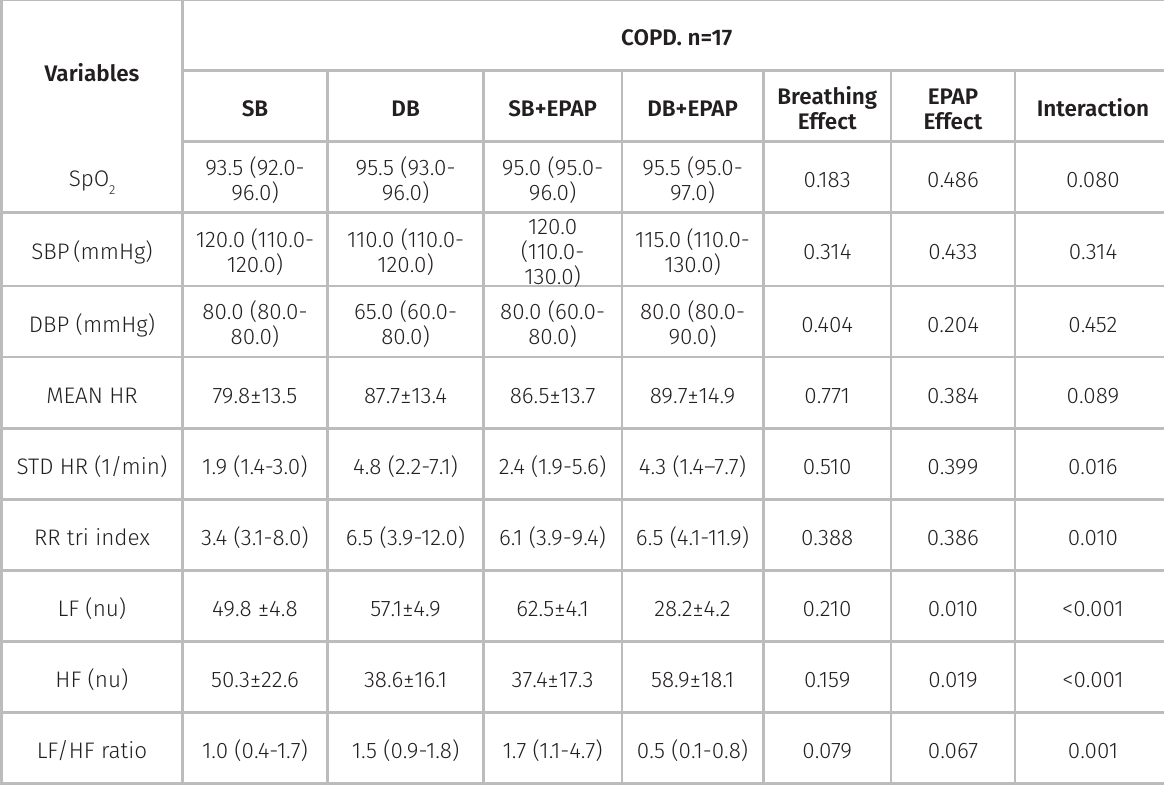
Table II. Cardiovascular response parameters during SB and DB, with and without EPAP